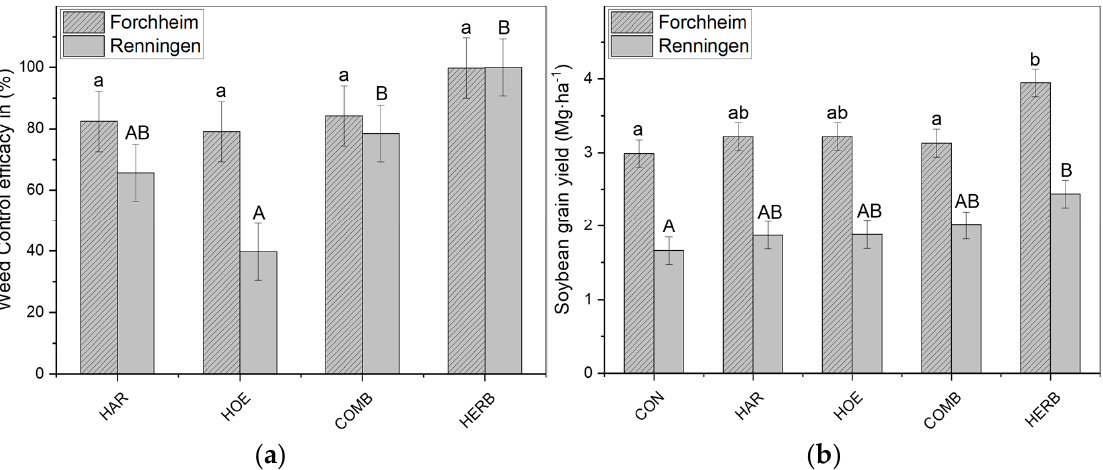
Figure 6. ( a ) Mean weed control efficacy in soybean three days after treatment; ( b ) soybean grain yield recorded in Forchheim 2018 and Renningen 2020. Variants with the same capital and small letter are not significantly different according to Tukey Honest Significant Difference test (HSD) at α ≤ 0.05. CON = untreated control, HERB = herbicide application, HAR = harrow, HOE = hoe at 4 km ∙ h − 1 in Forchheim 2018 and at 6 km ∙ h − 1 in Renningen 2020, COMB = combination of harrow and hoe.